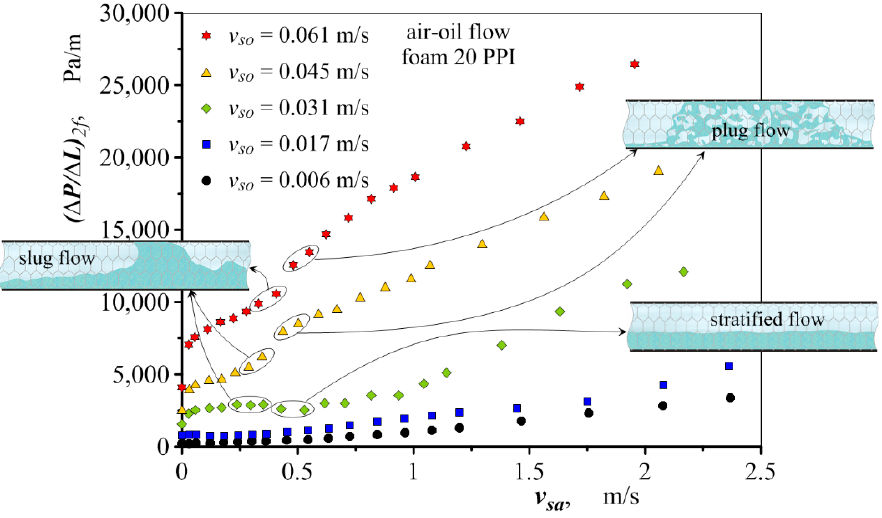
Figure 10. Measured pressure drop in air–oil flow as a function of phase velocity (flow through 20 PPI foam channel)